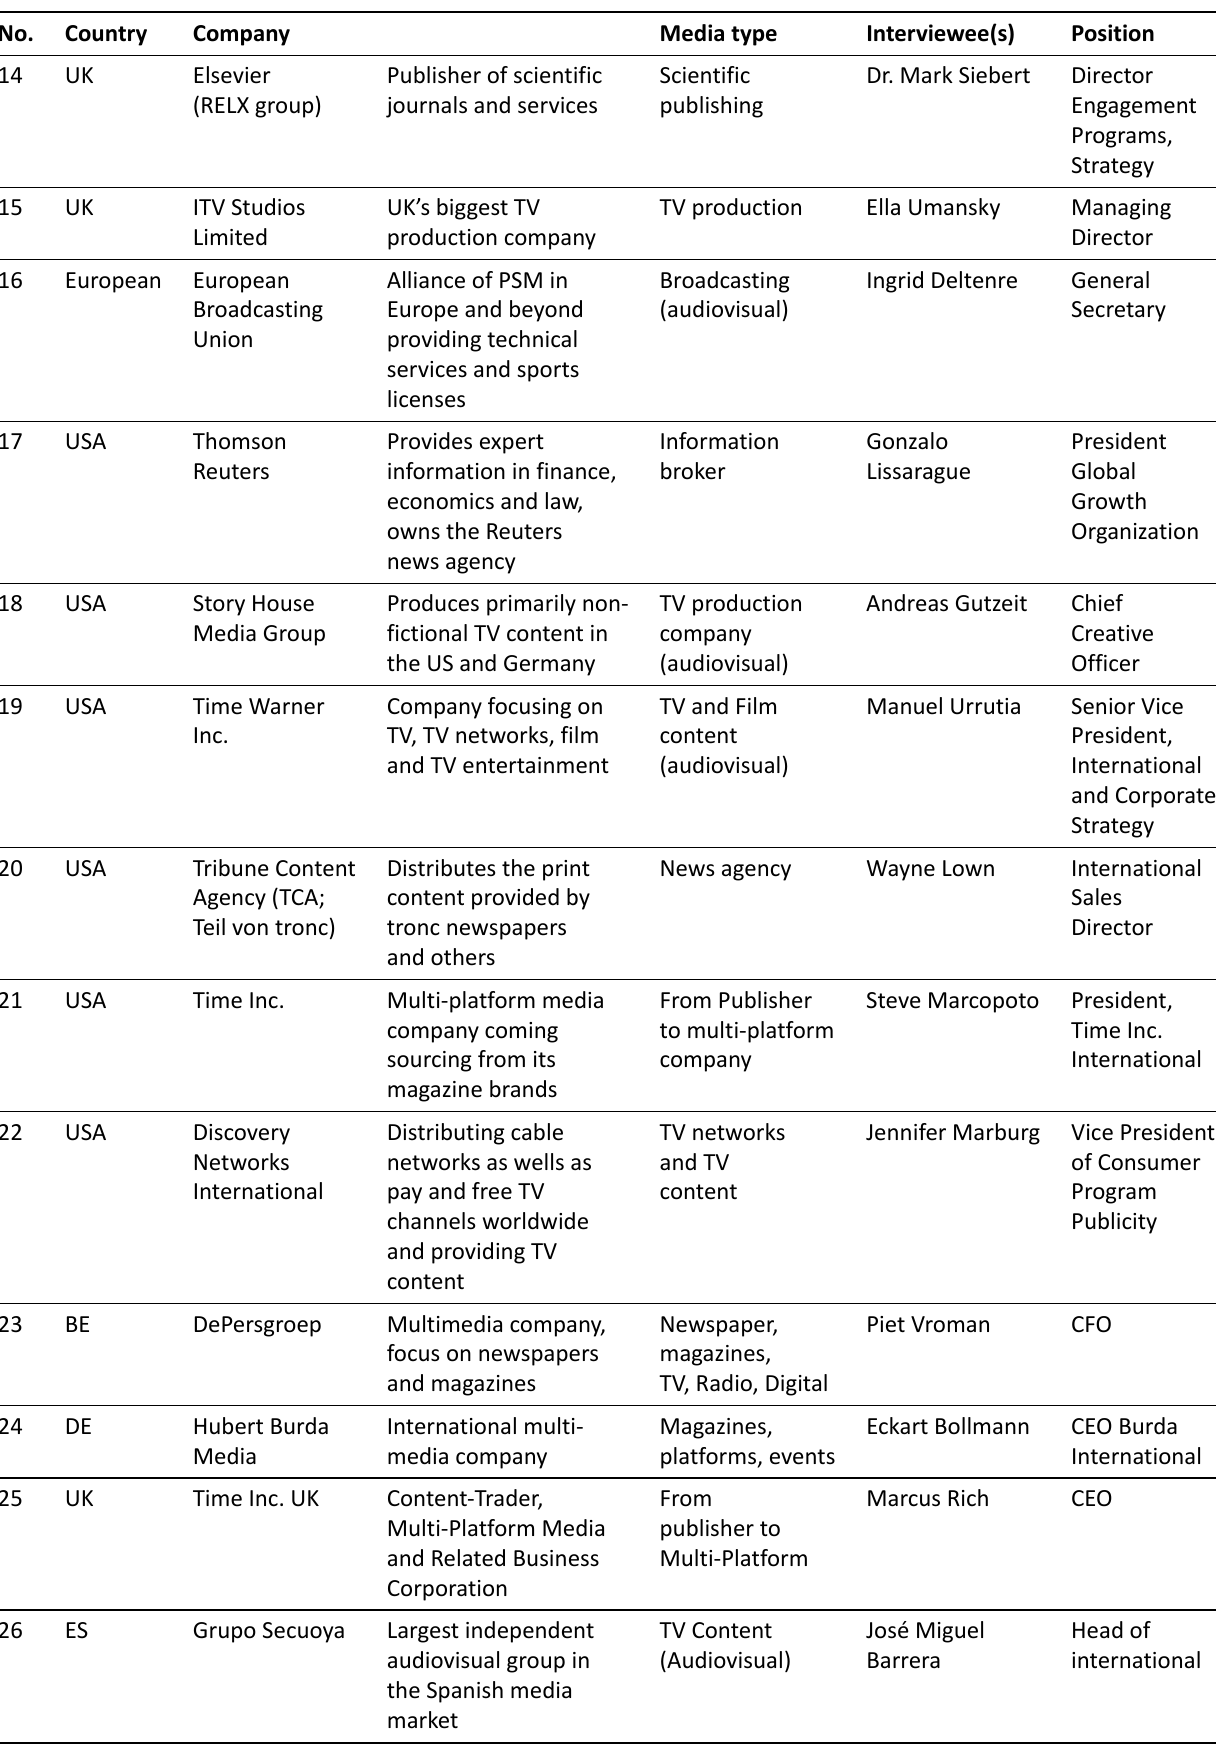
Table 1. Interview Sample (cont.)